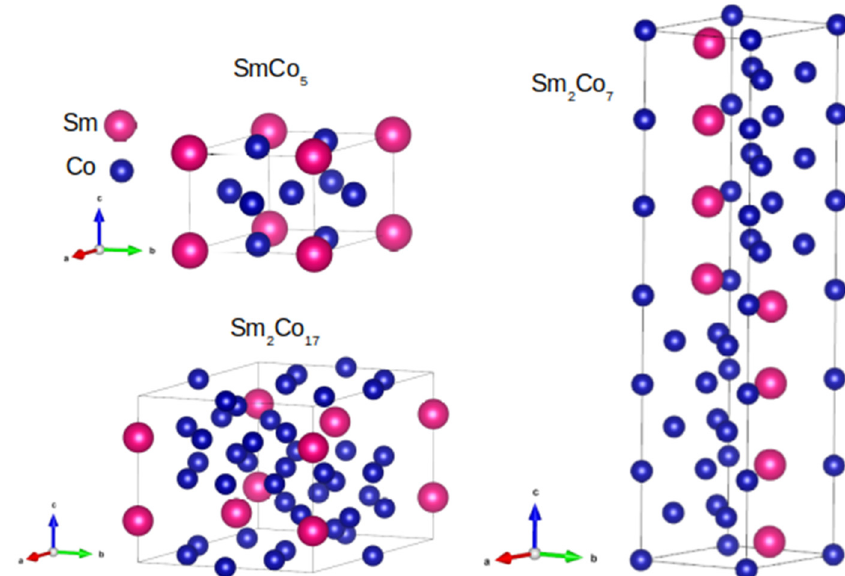
Figure 2. Crystal structures of the selected Sm-Co compounds.